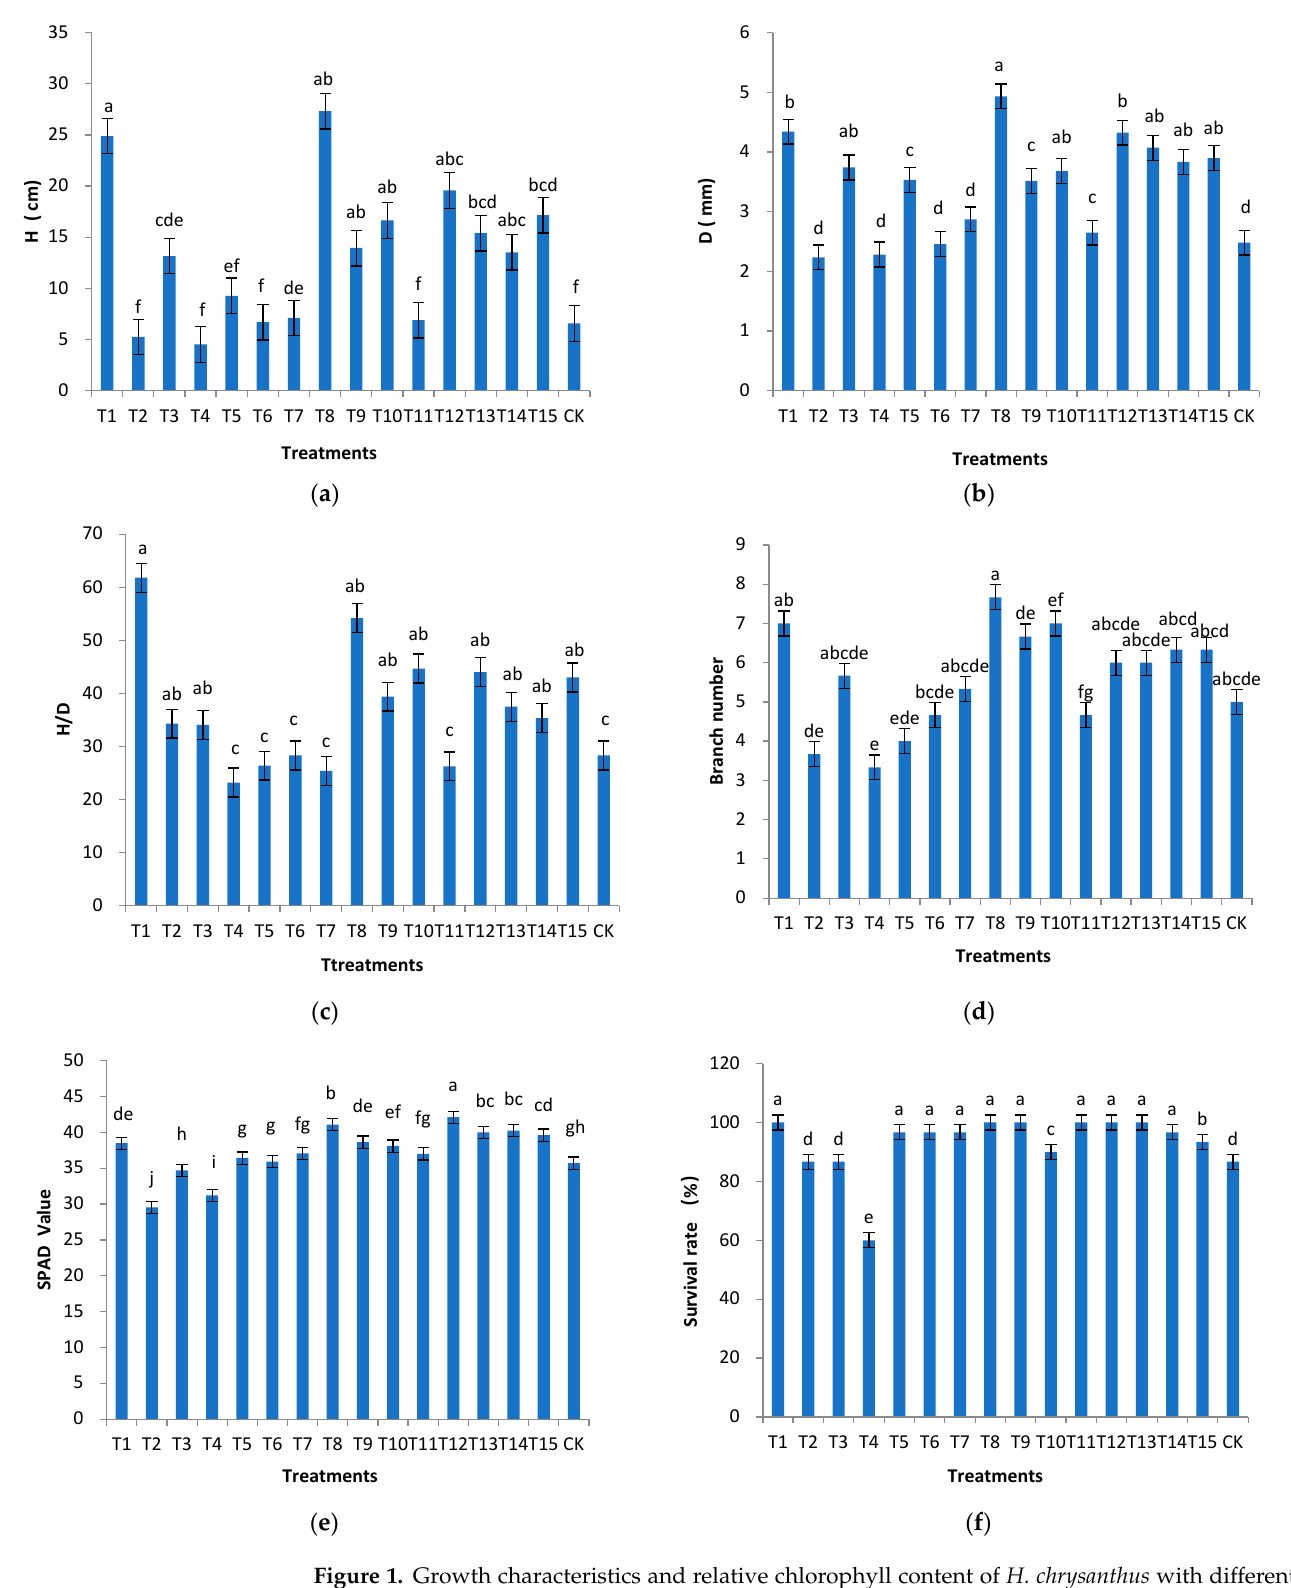
Figure 1. Growth characteristics and relative chlorophyll content of H. chrysanthus with different mixed substrates: ( a ) height (H, cm), ( b ) ground diameter (D, mm), ( c ) height–diameter ratio (H/D), ( d ) branch number, ( e ) relative chlorophyll content (SPAD value), and ( f ) survival rate (%). Significant differences between treatments are indicated by different lowercase letters (Tukey’s HSD test; p < 0.05; mean ± SE).